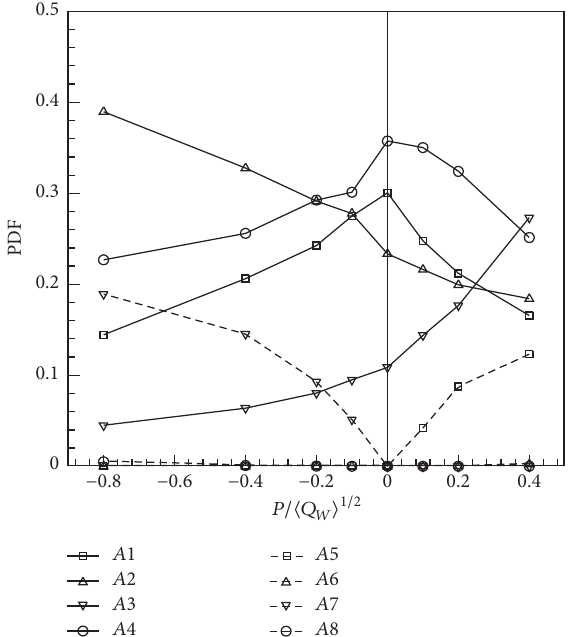
Figure 8: Occurrence probabilities of various topologies in the flame zone ( 𝑡 = 501 𝜇 s).